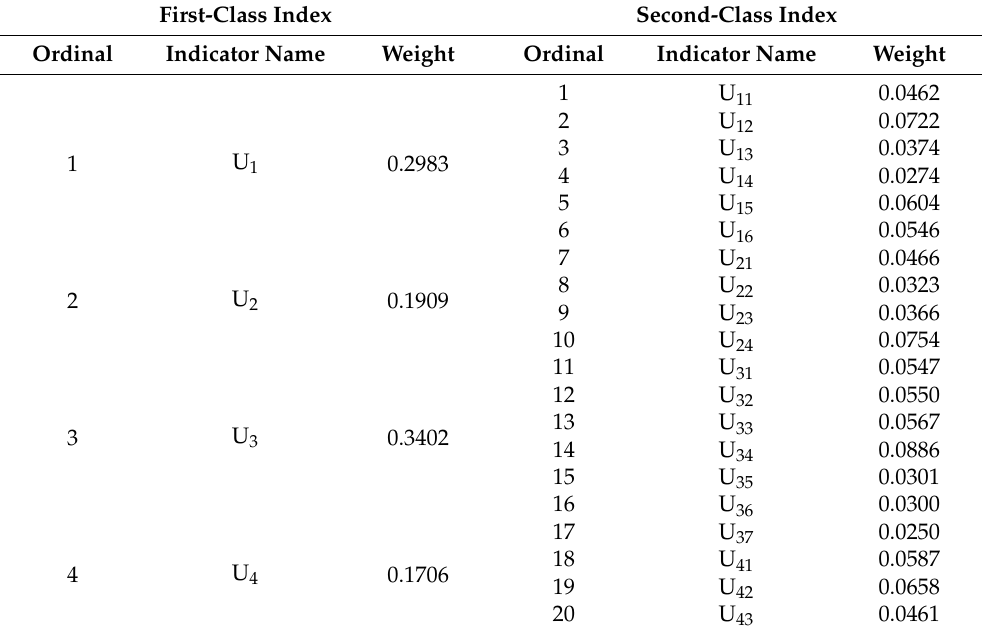
Table 2. Weights of indicators at each